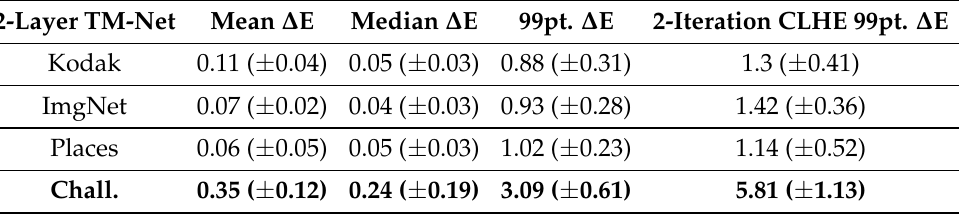
Table 1. ∆ E ( ± standard deviation) between the 2-layer TM-Net and CLHE . The final column com- pares the 2-layer TM-Net to 2-iteration CLHE .